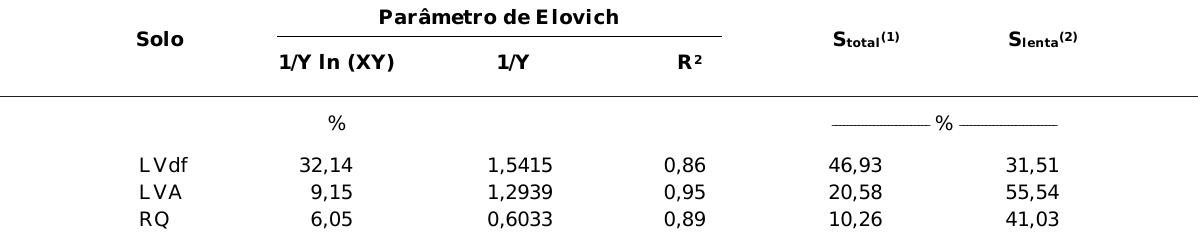
Latossolo Vermelho distroférrico (LVdf), Latossolo Vermelho-Amarelo (LVA) e Neossolo Quartzarênico